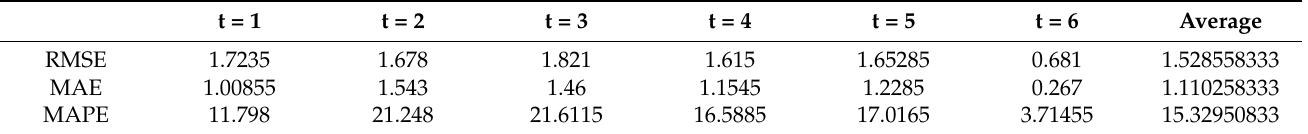
Table 12. Performance results of different univariate hybrid WSP models for West Virginia Hills region.